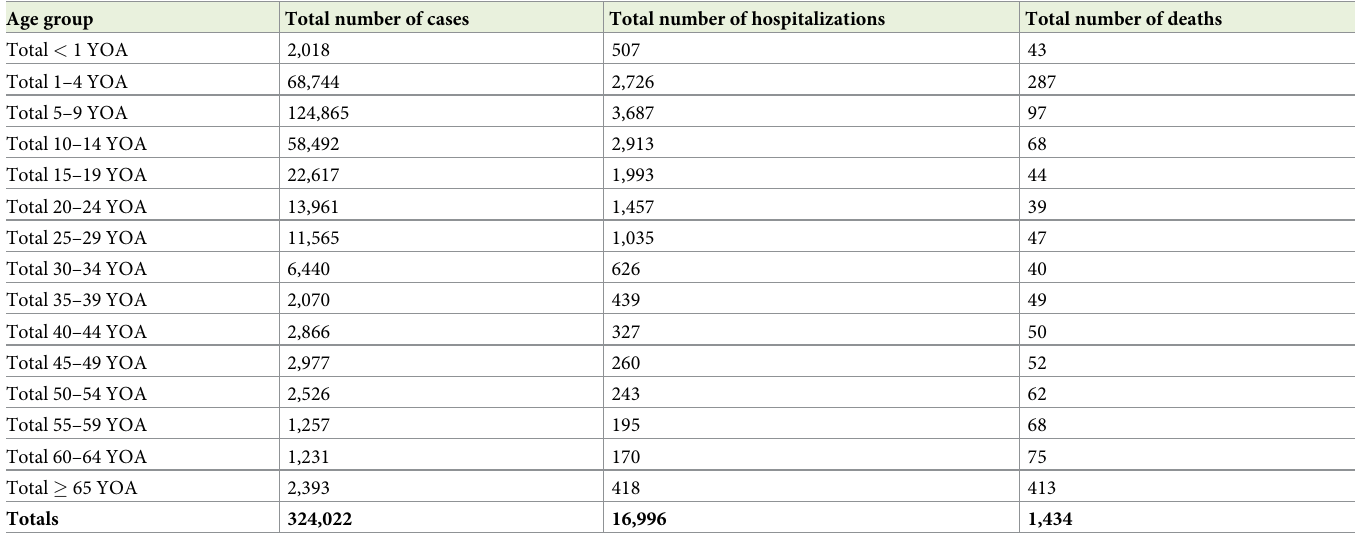
Table 2. Total numbers of cases, hospitalizations and deaths due to HAV in Mexico from 2000–2019 by age